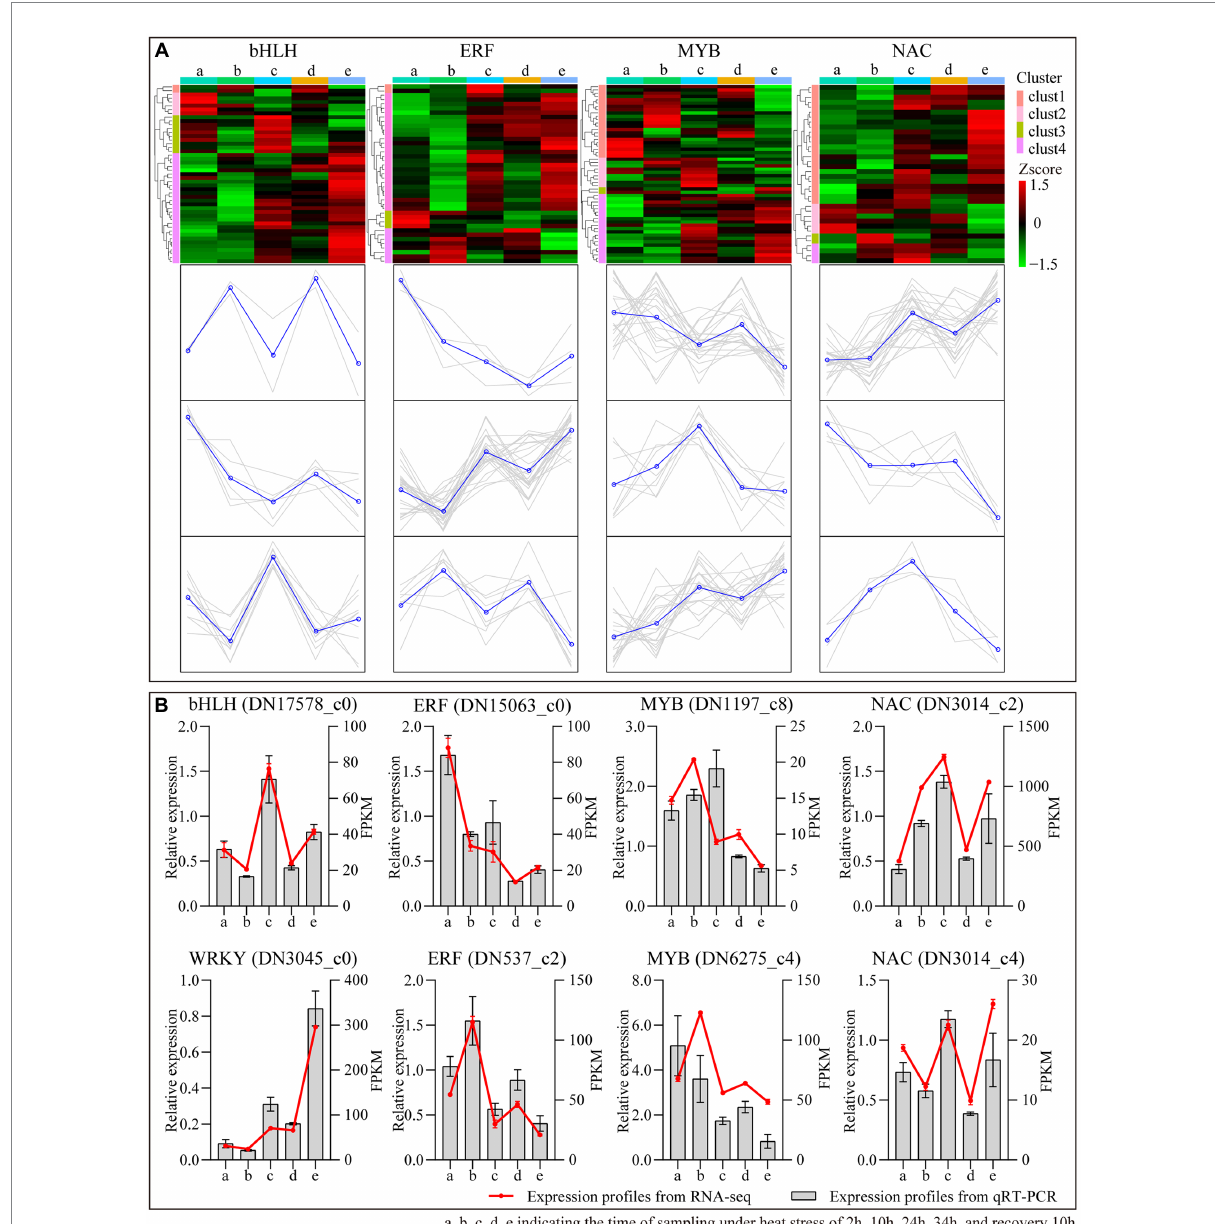
FIGURE 9 The differential expression pattern of the four TF families (MYB, NAC, and WRKY). (A) The differential expression pattern of the four TF families were depicted by a heatmap. (B) Validation of expression pattern of several TF genes by